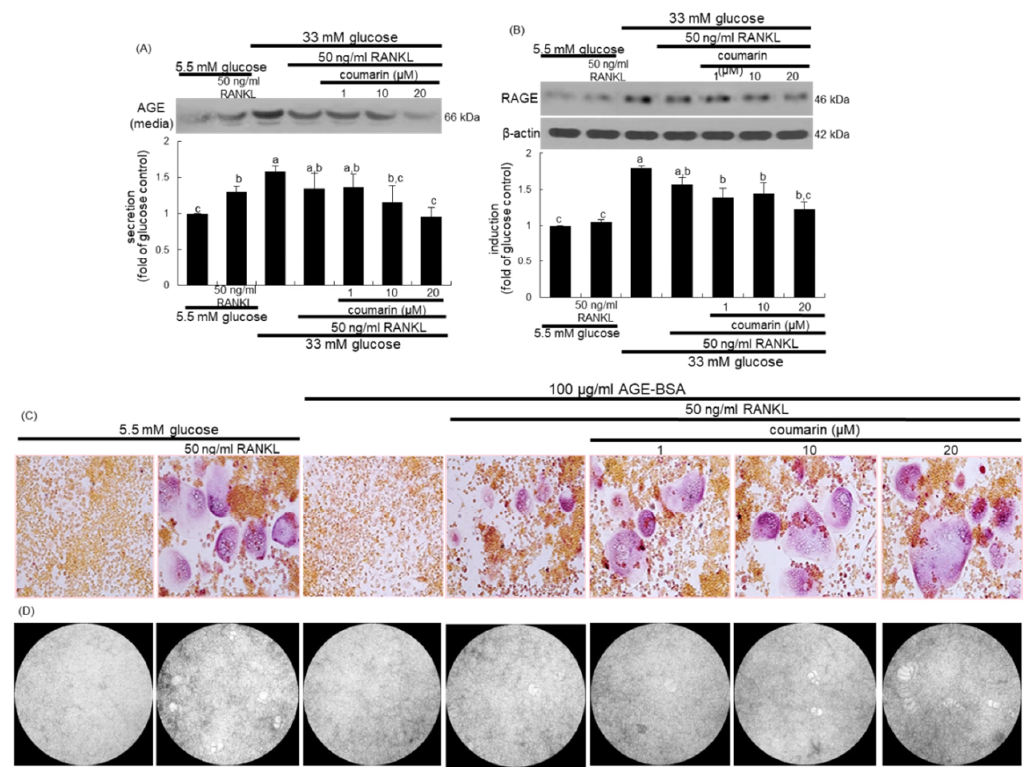
Figure 4. Inhibition of glucose ‐ induced advanced glycation end products (AGE) secretion ( A ) and receptor for AGE (RAGE) expression ( B ), and elevation of AGE ‐ induced osteoclast differentiation ( C ), and bone resorption ( D ) by coumarin in Raw 264.7 cells. Cells were cultured in α‐ MEM